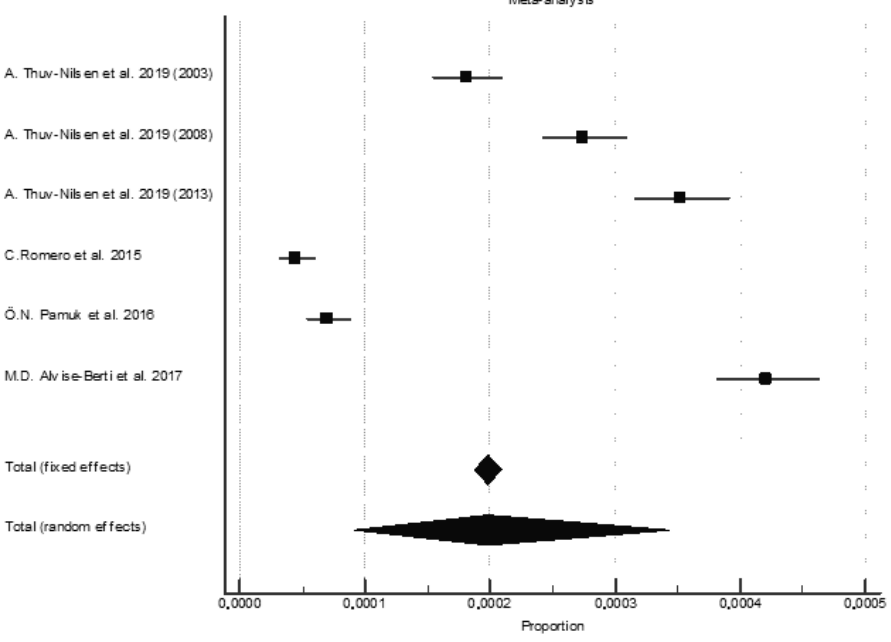
Figure 4. Pooled prevalence of total ANCA-associated vasculitis [11,12,18,30]. Table 5. Pooled prevalence of ANCA-associated vasculitis (number of studies included, 95% CI, and I 2 [heterogeneity]).